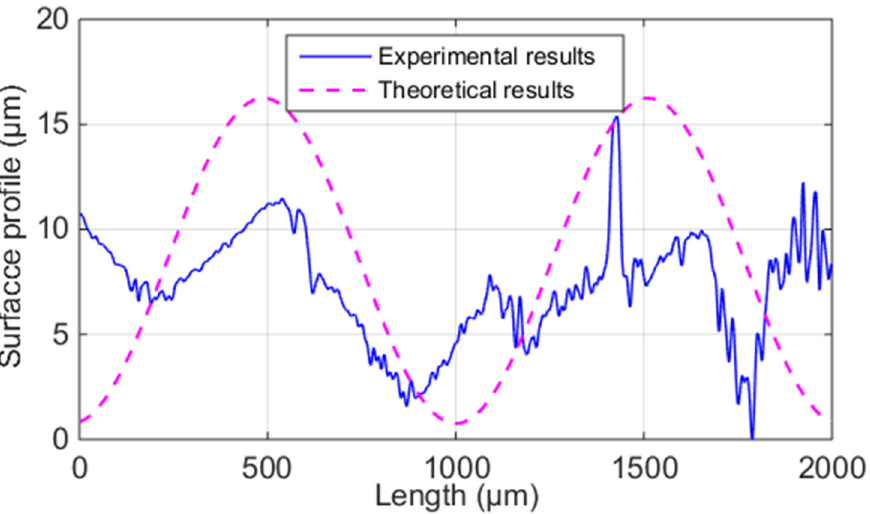
Figure 11. Theoretical and average experimental results of the surface profile of the ME samples parallel to the fiber direction. Table 4. The detailed results of SRPF-HB.